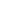
Figure 12 . Thermal spectrum of the representative microstate Π (100) random sample of microstates of N 0